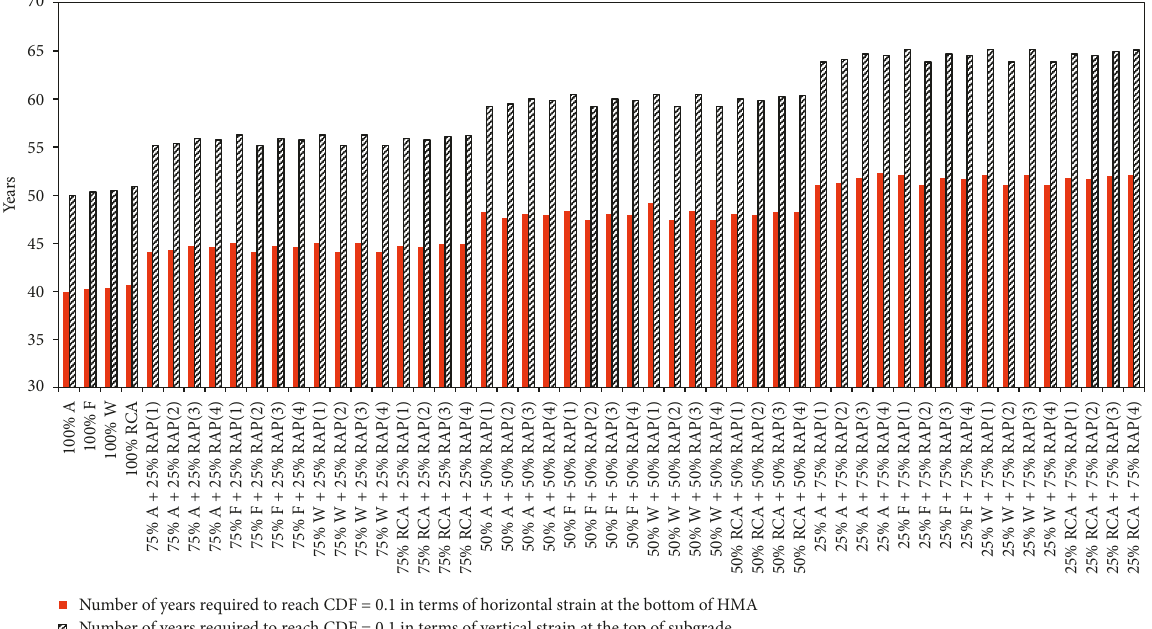
Number of years required to reach CDF = 0.1 in terms of horizontal strain at the bottom of HMA Number of years required to reach CDF = 0.1 in terms of vertical strain at the top of subgrade Figure 11: Number of years required to reach CDF